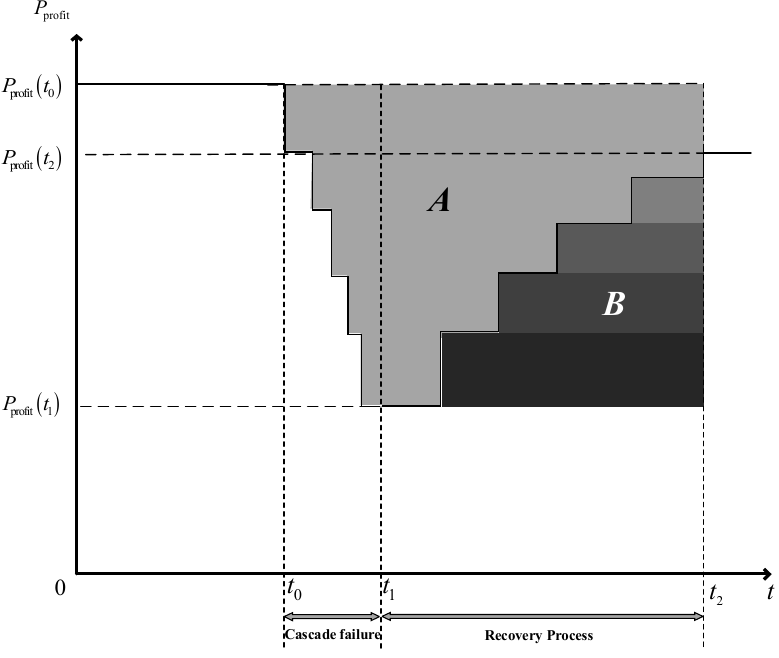
Figure 4. The performance change process of the metro network.